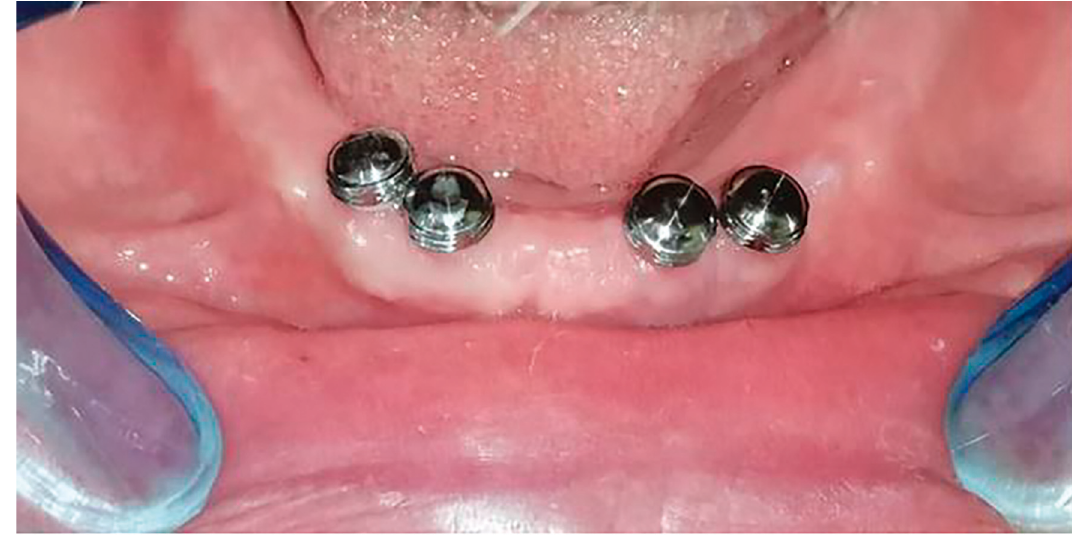
Figure 2: The processing caps and metal housings were inserted on the implant